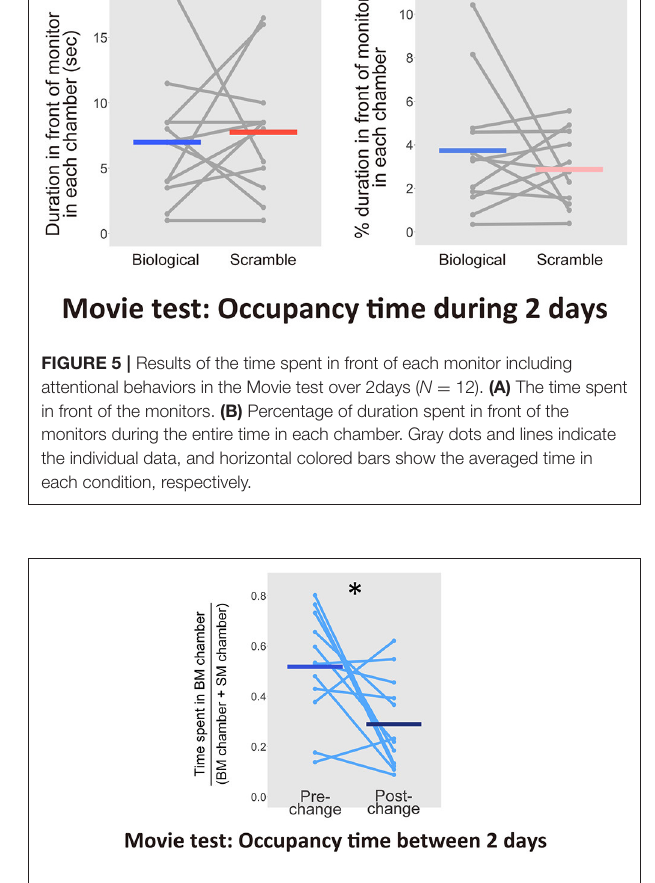
FIGURE 6 | Proportion of time spent in front of monitors with BM chamber between pre- and post-change of stimulus sets in the Movie test ( N = 12). Light blue dots and lines indicates the individual data, and horizontal bars show the averaged time. The difference between 2 days was significant (* p <